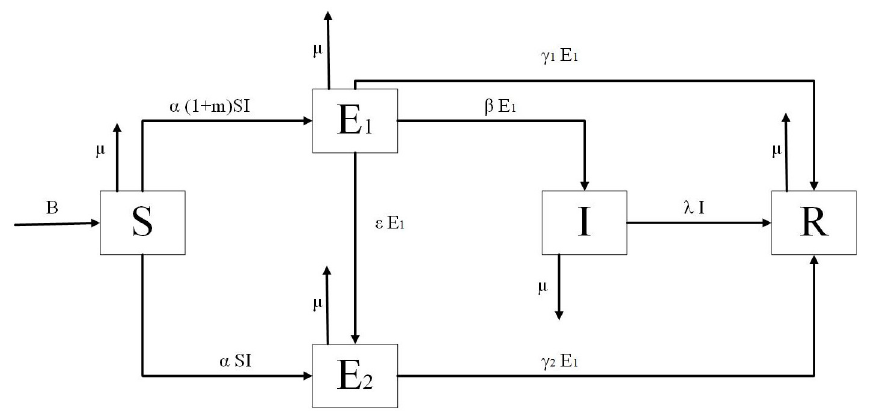
Fig 1. The flow diagram of the model.